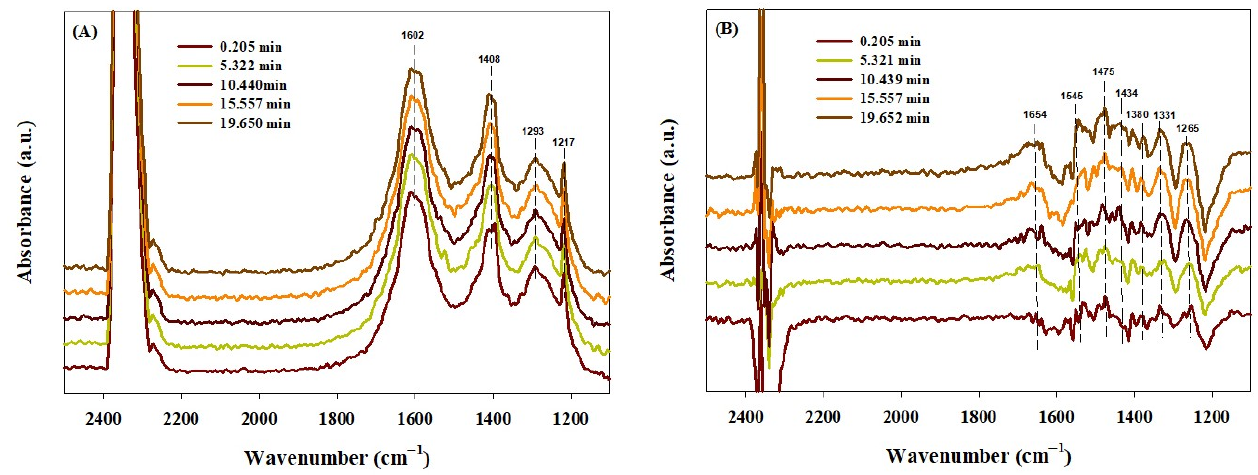
Figure 5. In situ DRIFTS spectra after adsorption of CO 2 on Co 0.1 Ce 0.9 O x (300) ( A ) and Co/CeO 2 (500) ( B ) at 40 °C. The feed gas is composed of 10 mol% CO 2 and 90 mol% He.